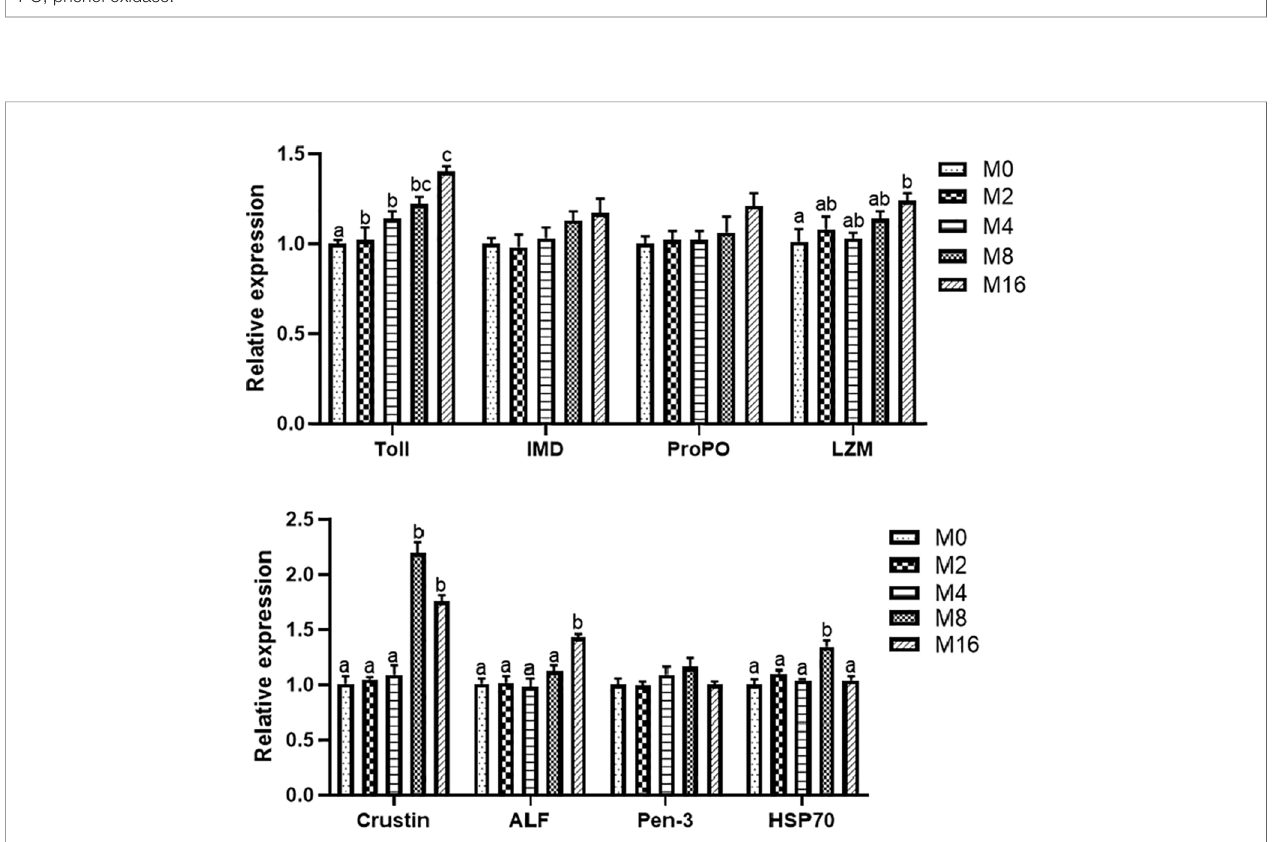
FIGURE 3 | Effects of dietary MOS on expression of immune-related genes in hepatopancreas of Litopenaeus vannamei . a,b,c Value bars not sharing the same superscript letter are signi fi cantly different as evaluated by Tukey ’ s test ( p < 0.05). IMD, immune de fi ciency; ProPO, pro-phenoloxidase; LZM, lysozyme; ALF, anti- lipopolysaccharide factor; Pen-3, penaeidins-3; HSP70, heat shock protein 70; MOS, mannan oligosaccharide.